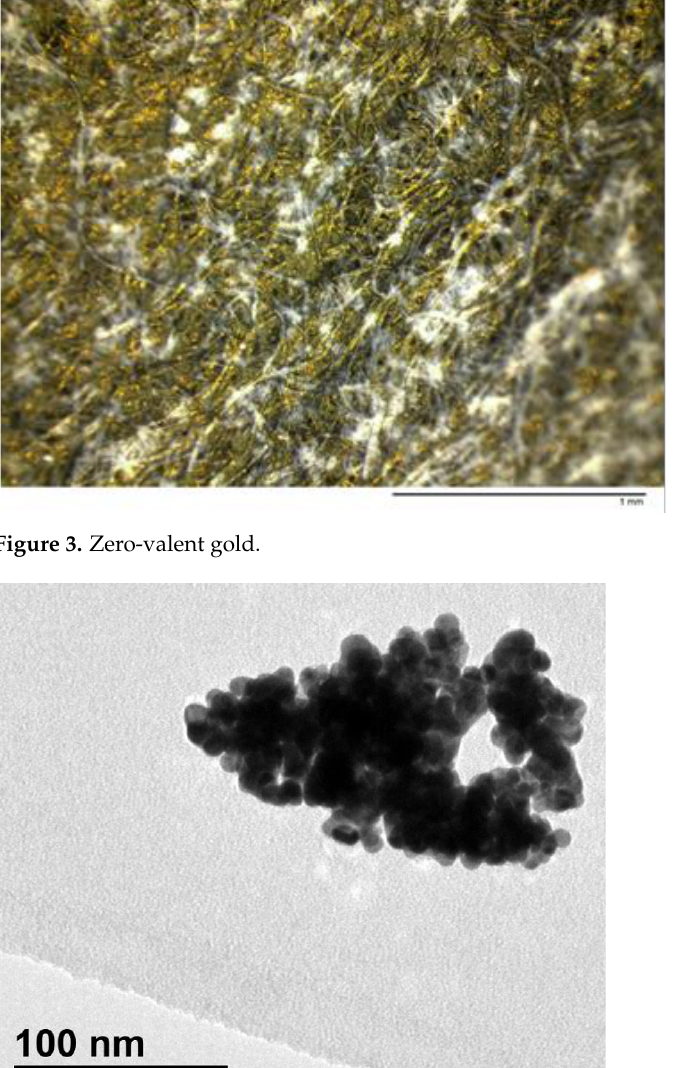
Figure 4. TEM image of the precipitated zero-valent gold.